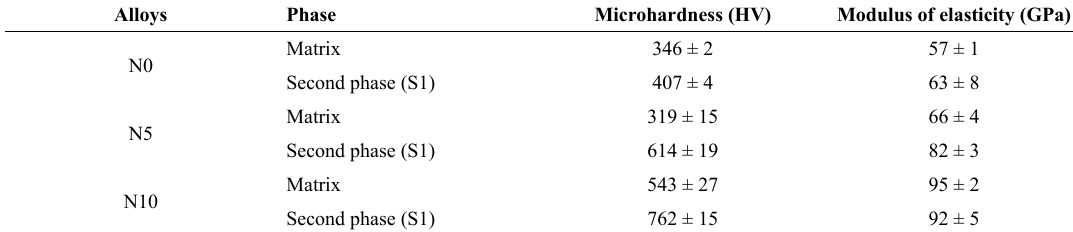
Ni Zr ). 50 50-x x